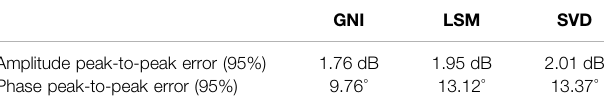
error of the quiet zone obtained by the GNI algorithm is 0.88 dB and the phase error is 3.86 ° . In order to facilitate the observation of fl uctuations, we selected a cross section indicated by the black dashed curve in Figure 7 . And the cross-sectional amplitude error and phase error is shown in Figure 8 .